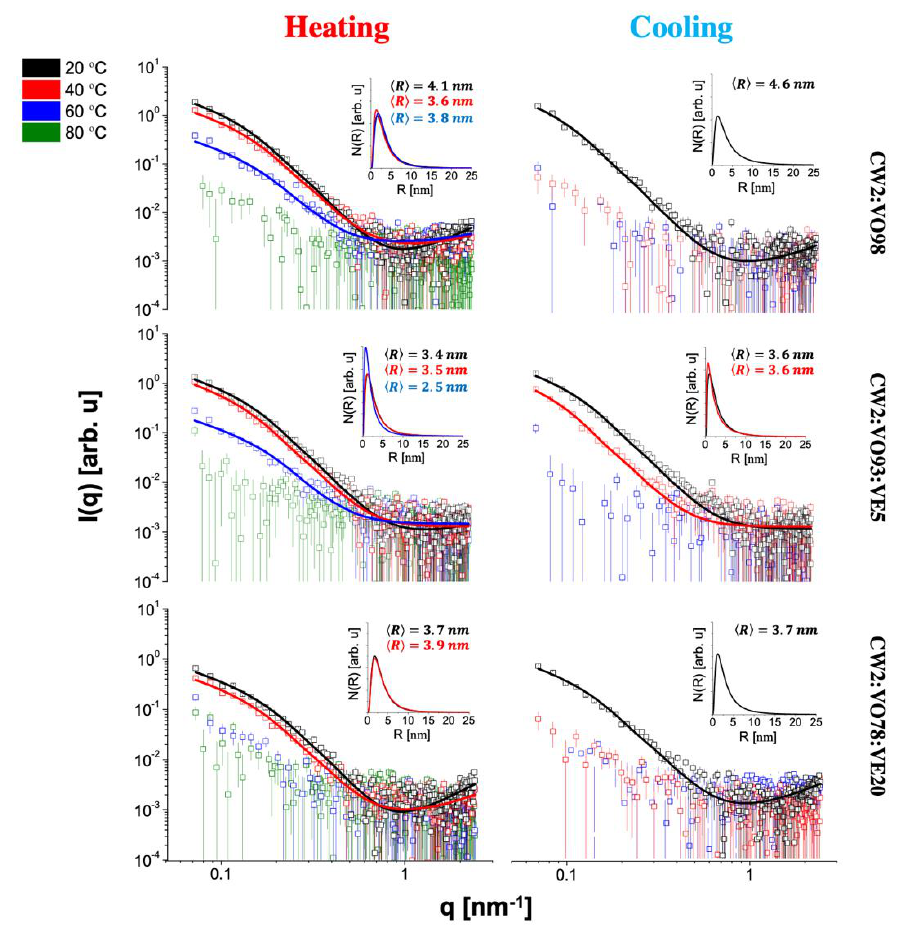
Figure 6. SAXS data for the CW organogels on heating and on cooling (open symbols) and fitted with Equation (12) (continuous lines). The insets correspond to the cylinder radius size distributions. The average radius for each distribution is shown as well.